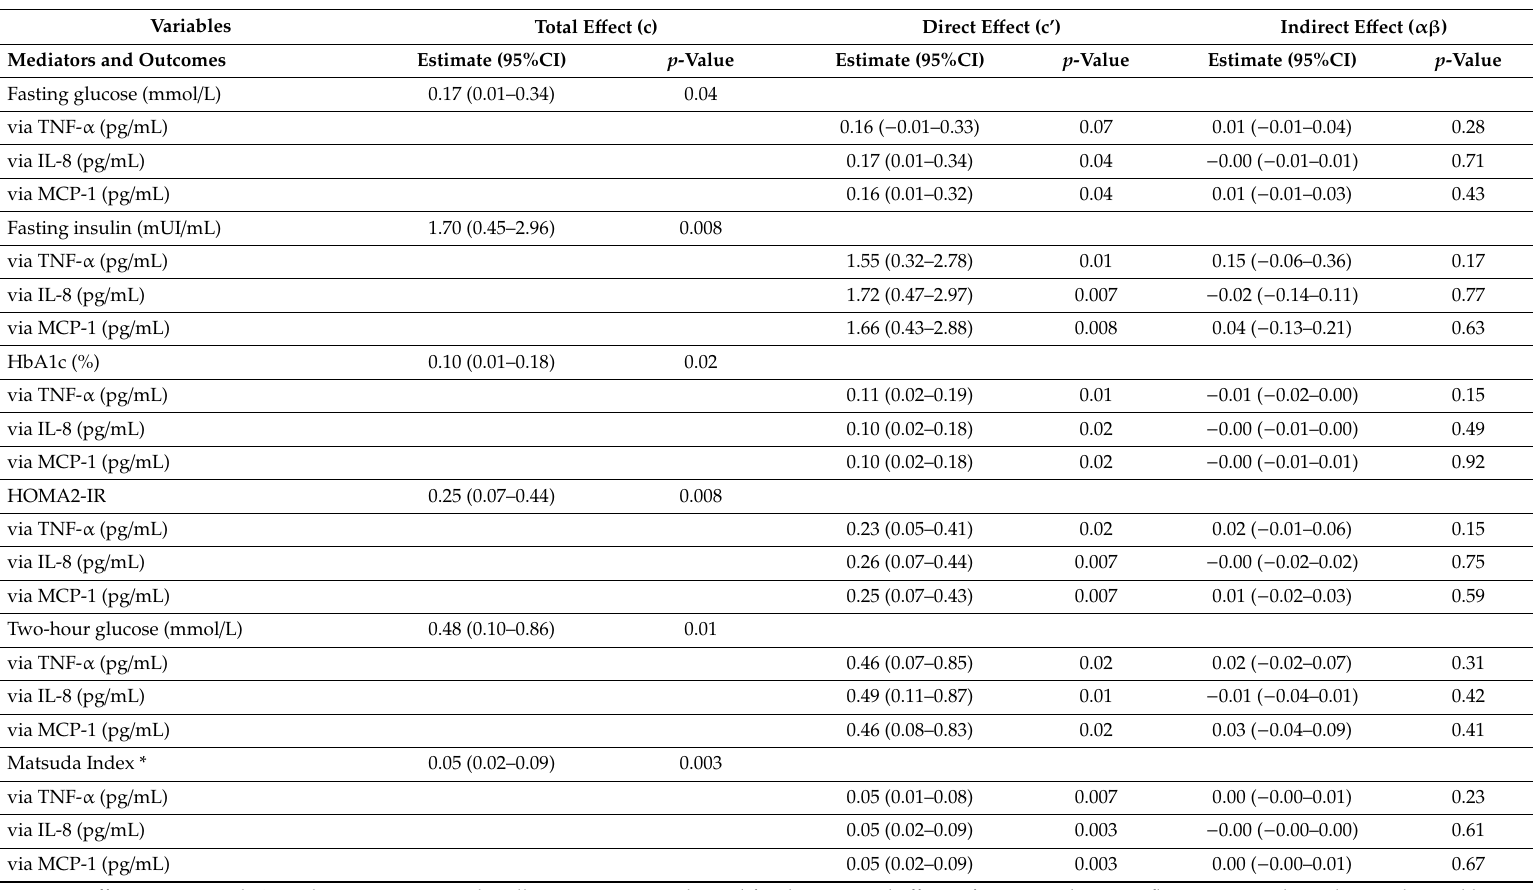
Table 3. Total, direct and indirect e ff ects of E-DII on markers of T2D risk with inflammatory cytokines as mediators in black SA